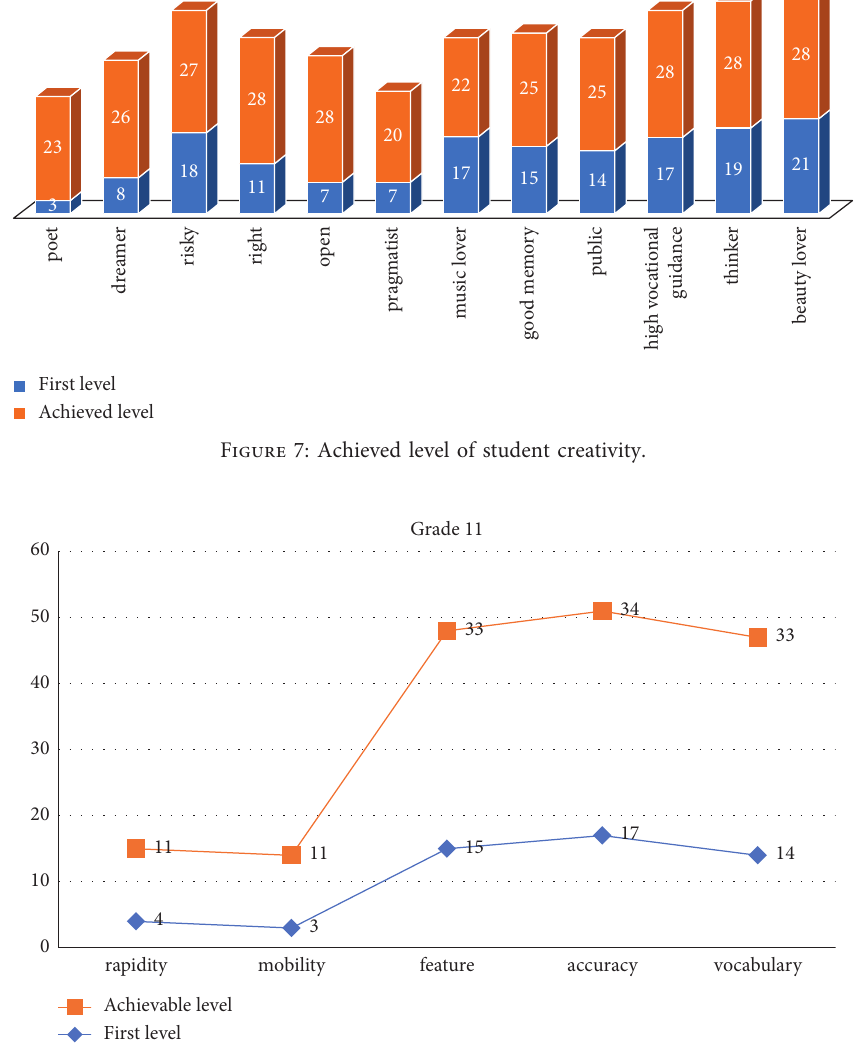
Figure 8: Achieved level of creativity and communicative competence of 10th-grade